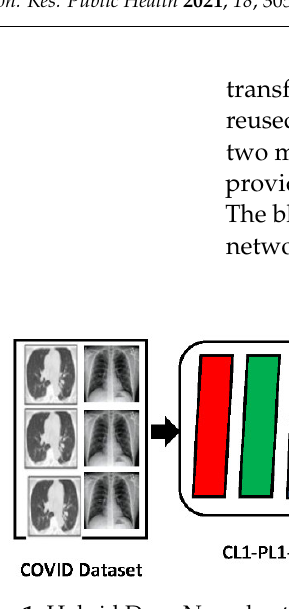
Figure 1. Hybrid Deep Neural network (HDNNs) architecture for COVID-19 detection consists of a dropout layer (DL), a convolutional layer (CL), a pooling layer (PL) with LSTM blocks, and a fully connected (FC) layer.